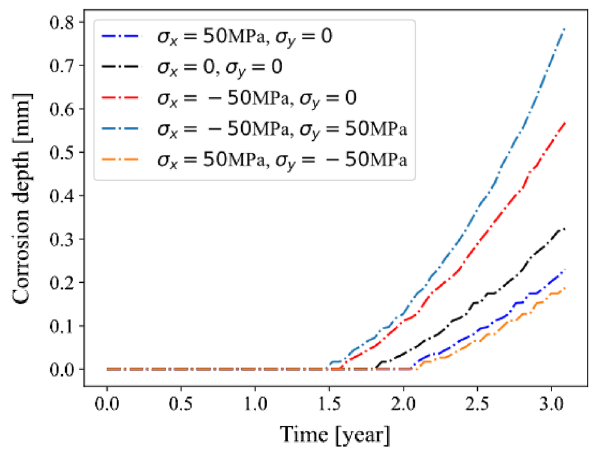
Figure 11. Corrosion depth under different stress